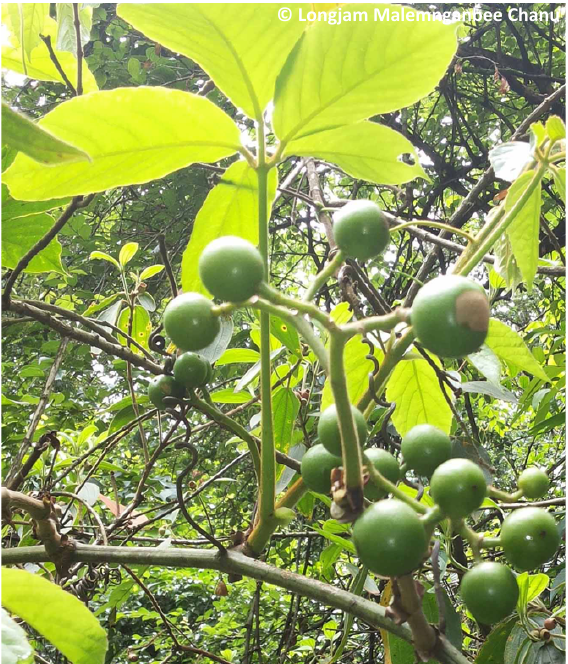
Image 5. Tetrastigma obovatum (M.A. Lawson)